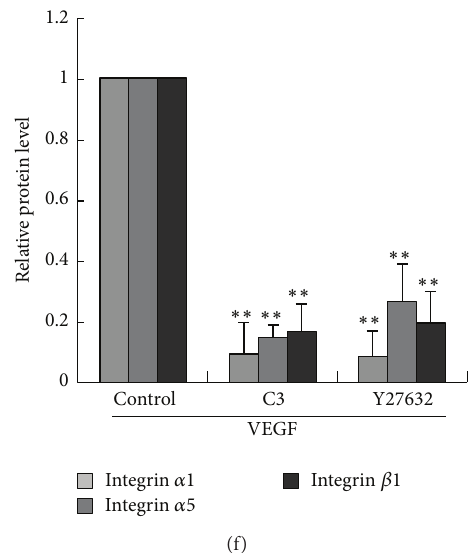
Figure 4: VEGF induces angiogenesis and high integrin expression in differentiated MSCs via the Rho signaling pathway. (a) MSCs were cultured with EC differentiation medium in the presence or absence of the Rho inhibitor C3 transferase or the Rho-associated protein kinase (ROCK) inhibitor Y27632 for 4d and then MTT assay was performed to test cellular viability. (b) MSCs were pretreated with either the C3 or Y27632 in the present of VEGF for 4 d and then continuously cultured in EC differentiated medium for 3 d. Matrigel angiogenesis assays were then performed. (c) Capillary-like structures were quantified by measuring the polygonal network. (d) The expression of integrins 𝛼 1, 𝛼 5 and 𝛽 1 during endothelial differentiation of MSCs was estimated by real-time PCR. ∗∗ 𝑃 < 0.01 , 𝑛 = 3 . (e) Western blotting assay for integrins 𝛼 1, 𝛼 5 and 𝛽 1. (f) The relative quantification of the protein expression. ∗∗ 𝑃 < 0.01 , 𝑛 = 3